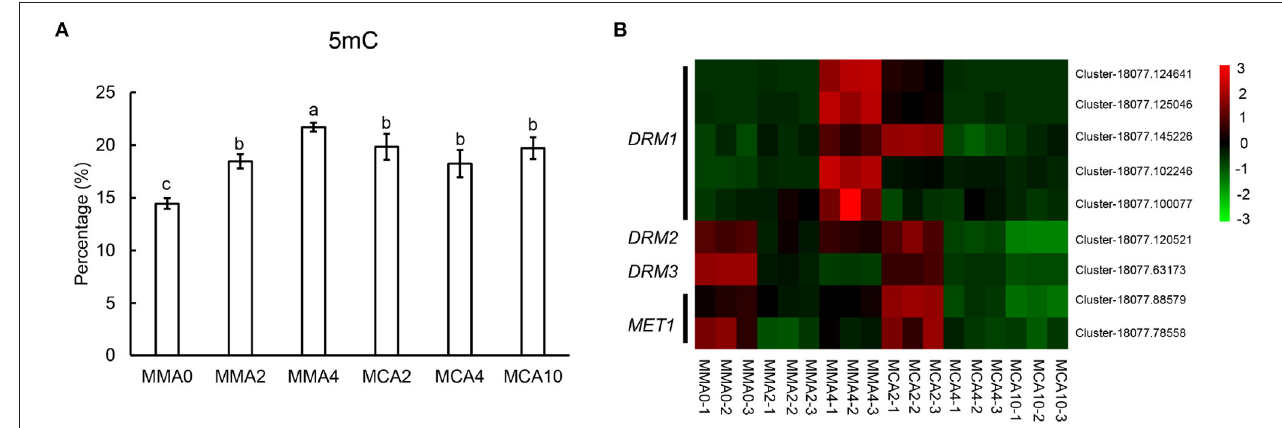
FIGURE 7 | Factors related to embryogenicity. (A) Contents of 5 mC showing global methylation levels of tissue of different treatments. (B) Heatmap of DOMAINS REARRANGED METHYLASE (DRM) and DNA methyltransferase 1 (MET1) . Significant differences are indicated by different letters ( P < 0.05). Mean ± SD, n =